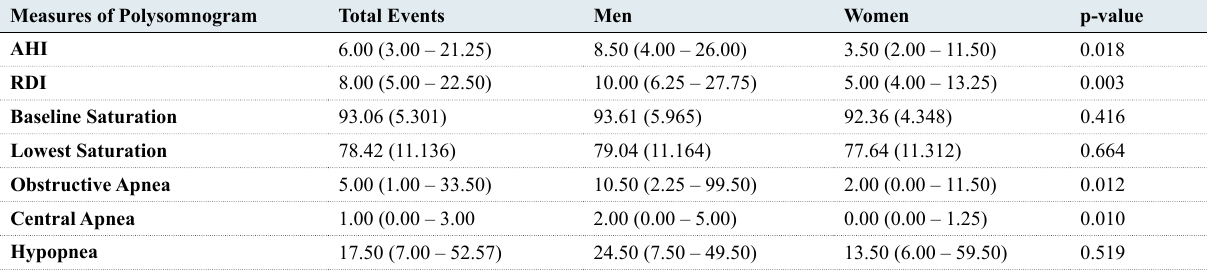
Figure 3: The severity of SRBD in relationship to gender among patients with Overlap Syndrome 62.5% (15/24) of patients with COPD, 55.55% (10/18) patients with Bronchial Asthma, 50% (1/2) patients with ILD and 50% (3/6) patients with Post-TB Bronchiectasis had evidence of Table 1: Results of the Polysomnogram in Respiratory Symptom Complex patients with SRBD Measures of Polysomnogram